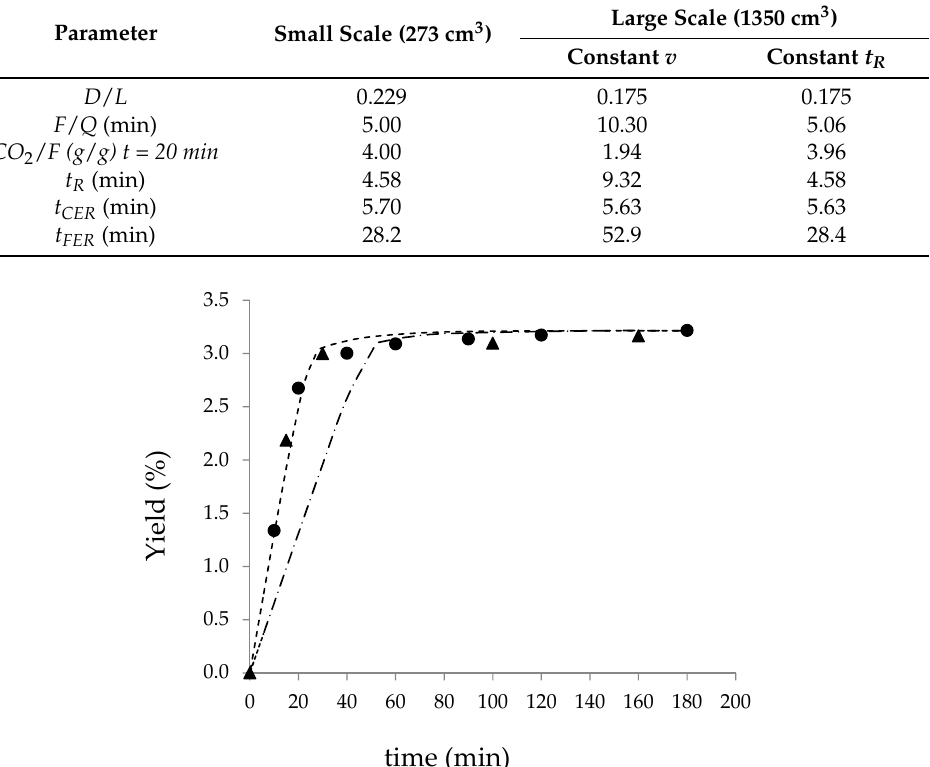
Table 4. BIC model prediction of Mortiño SFE kinetics at 30 MPa and 313 K in a large-scale extraction cell (1350 cm 3 ).